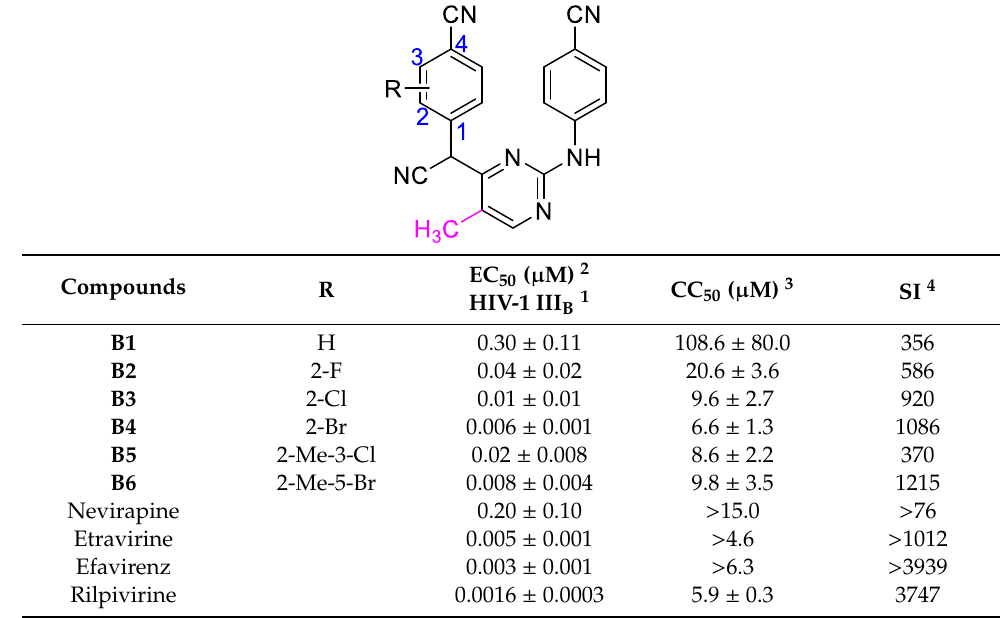
Table 2. Activity and cytotoxicity against HIV-1 (III B ) strains in MT-4 cells of compounds B1 – B6 .